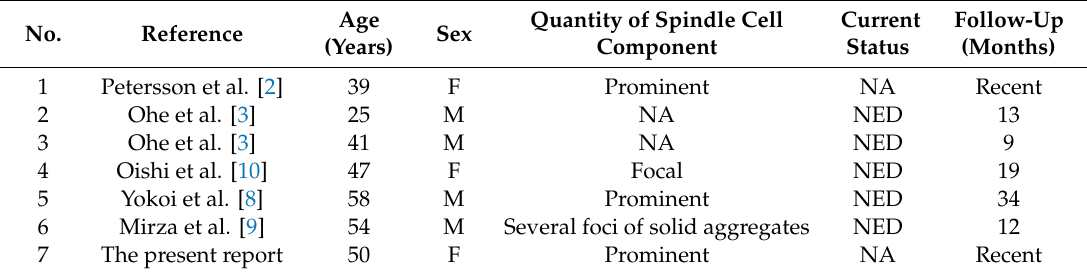
Table 2. Reported cases of biphasic thyroid-like low-grade nasopharyngeal papillary adenocarcinoma with a spindle cell